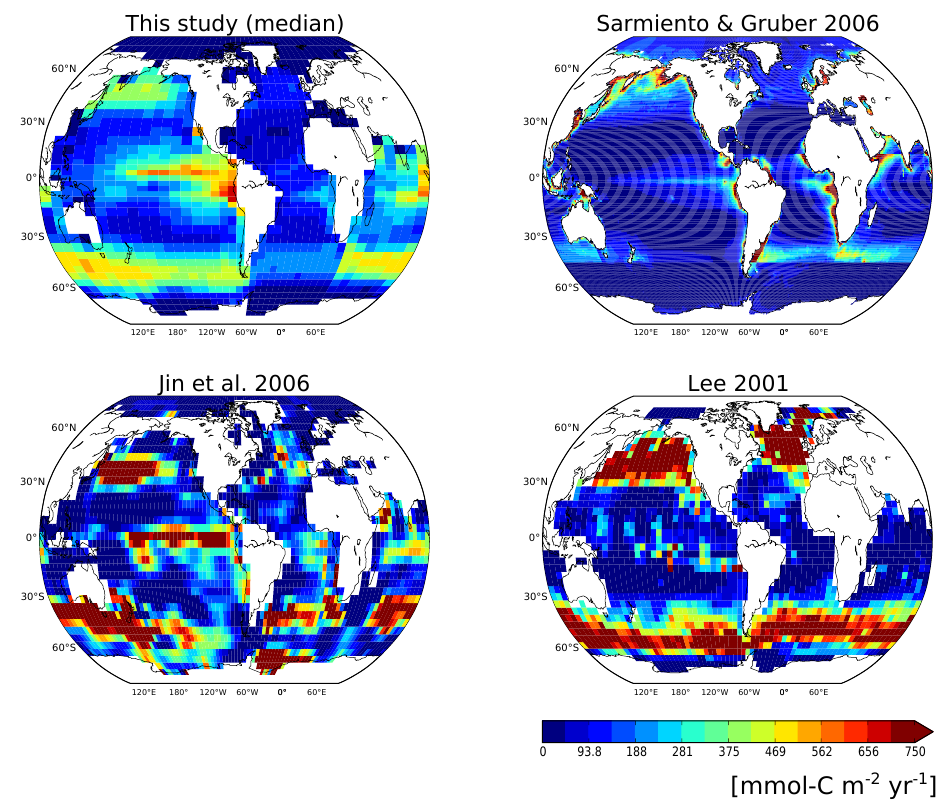
Figure 10. Observationally constrained CaCO 3 export fields as estimated by different studies. Global total export is estimated to be 0.5 by Sarmiento and Gruber (2006), 1.14 by Jin et al. (2006), 1.1 by Lee (2001), and 0.90Gt Cyr − 1 by this study.